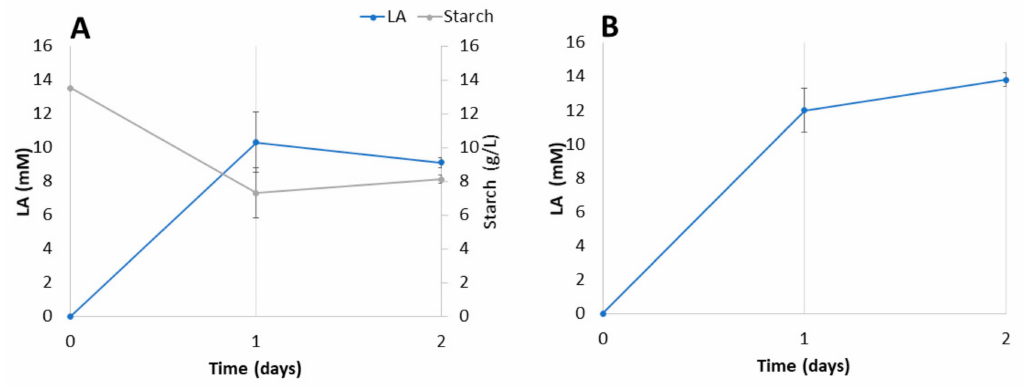
Figure 6. LA production in T. amestolkiae – L. plantarum M9BG6-B2 consortia growing with industrial starch waste ( A ) or bagasse ( B ) as carbon